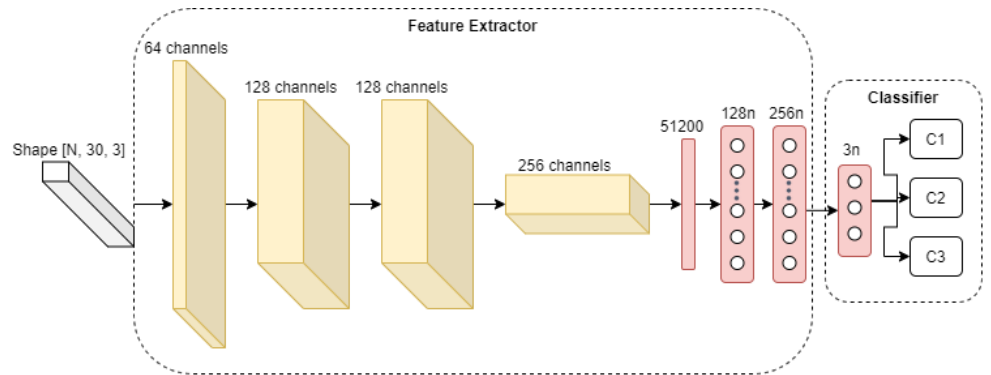
Figure 4. Convolutional neural network used for activity classification.